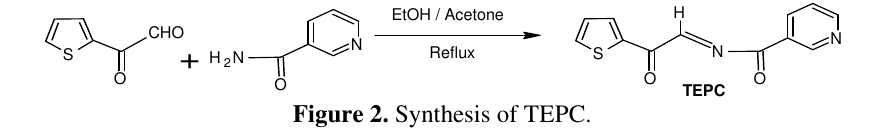
Figure 2. Synthesis of